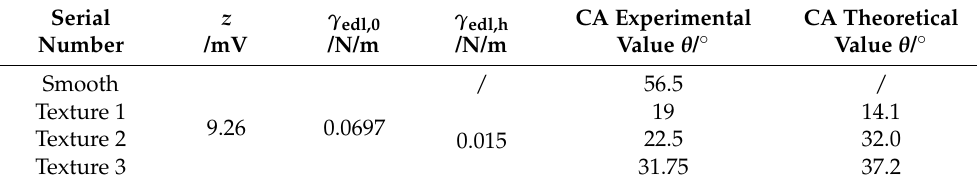
Figure 3. Static contact angle of different surfaces: ( a ) smooth surface; ( b ) Textured surface 1; ( c ) Textured surface 2; and ( d ) Textured surface 3. ( c ) Textured surface 2; and ( d ) Textured surface 3. Table 2. Prediction of contact angle (CA) on micro-square-convex surfaces. Table 2. Prediction of contact angle (CA) on micro-square-convex surfaces.